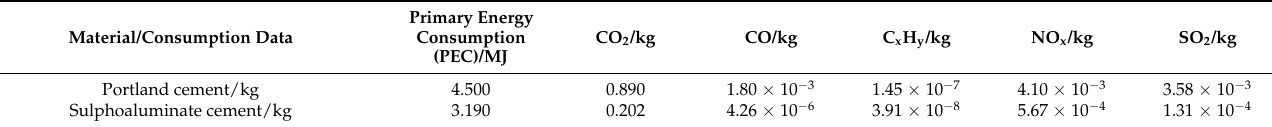
Table 3. Basic inventory